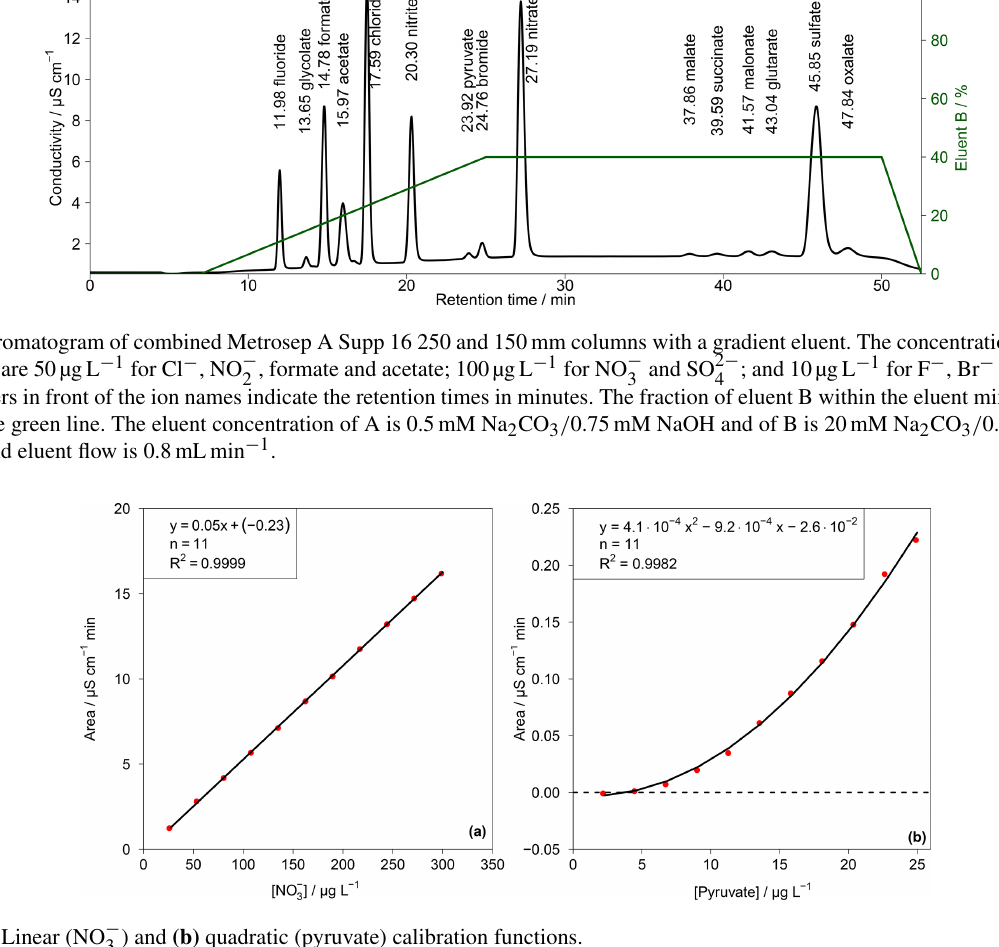
blank values plus 3 times the standard deviation (3 σ ).